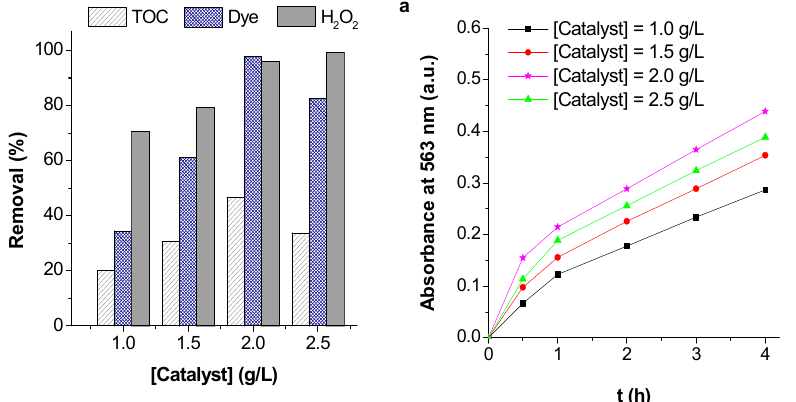
Figure 7. Influence of catalyst concentration in orange II dye and TOC removals and H 2 O 2 consumption after 4 h ( a ) and evolution of hydroxyl radical formation ( b ) ([OII] a) = 0.1 mM or [OII] b) = 0.0 mM, [H 2 O 2 ] = 6.0 mM, T = 30 ◦ C and pH initial = 3.0). Adapted from Rodrigues et al.